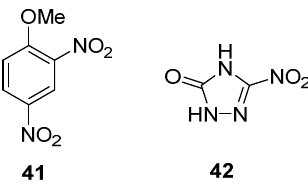
Figure 4. Chemical structures of DNAN (41) and NTO (42).